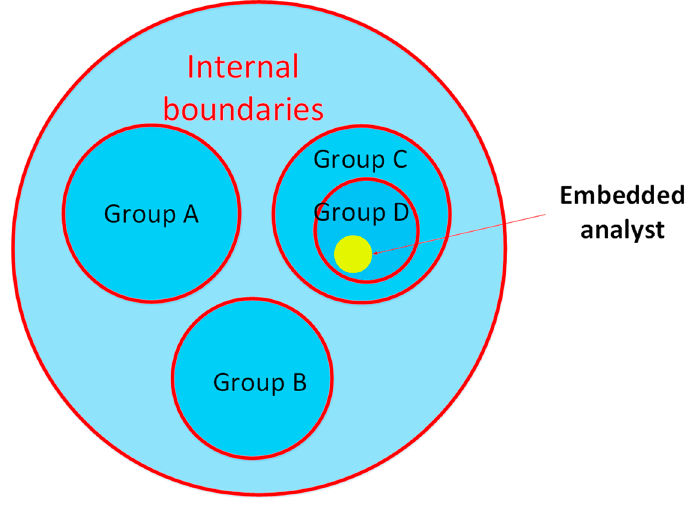
Figure 4. The embedded communication activity.